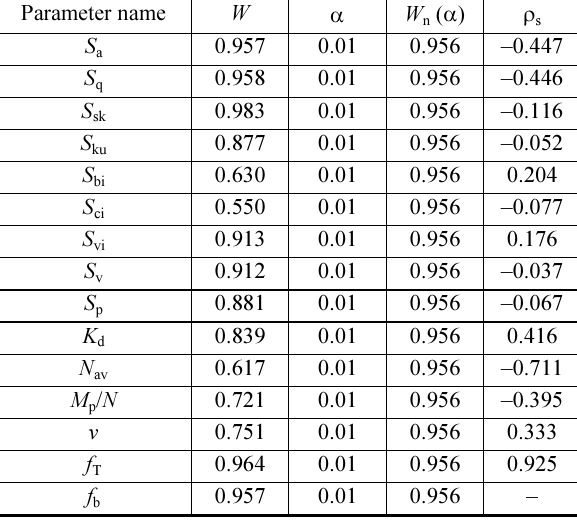
Table 2. Shapiro-Wilk test results and Spearman’s rank